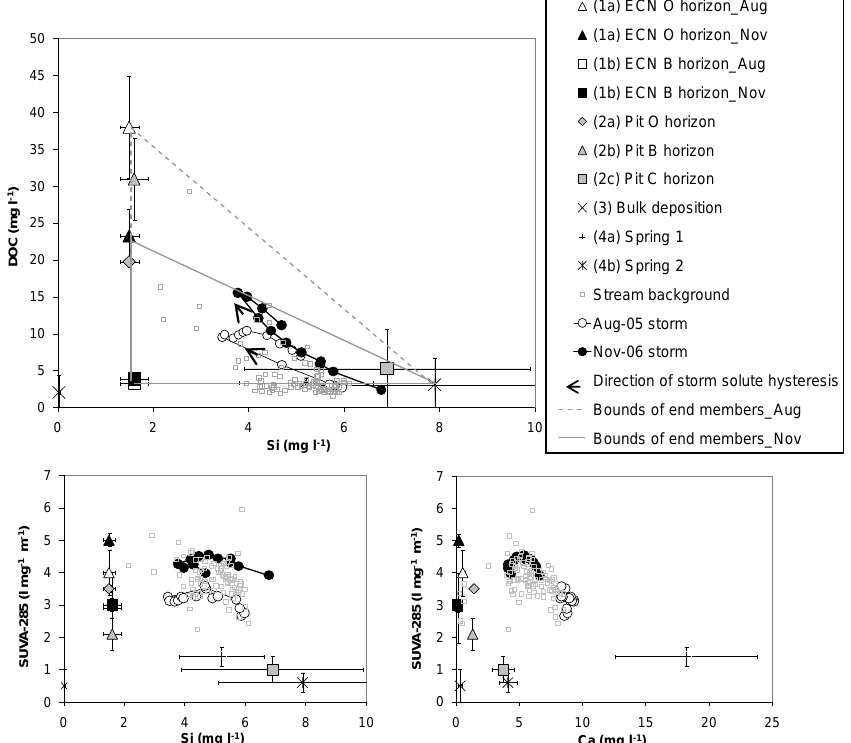
Fig. 6. End-member mixing diagrams comparing streamwaters during storms and during background weekly stream monitoring with com- positions of catchment source waters using solute tracer pairs: (a) DOC vs Si, (b) SUVA-285 vs Si, and (c) SUVA-285 vs. Ca.